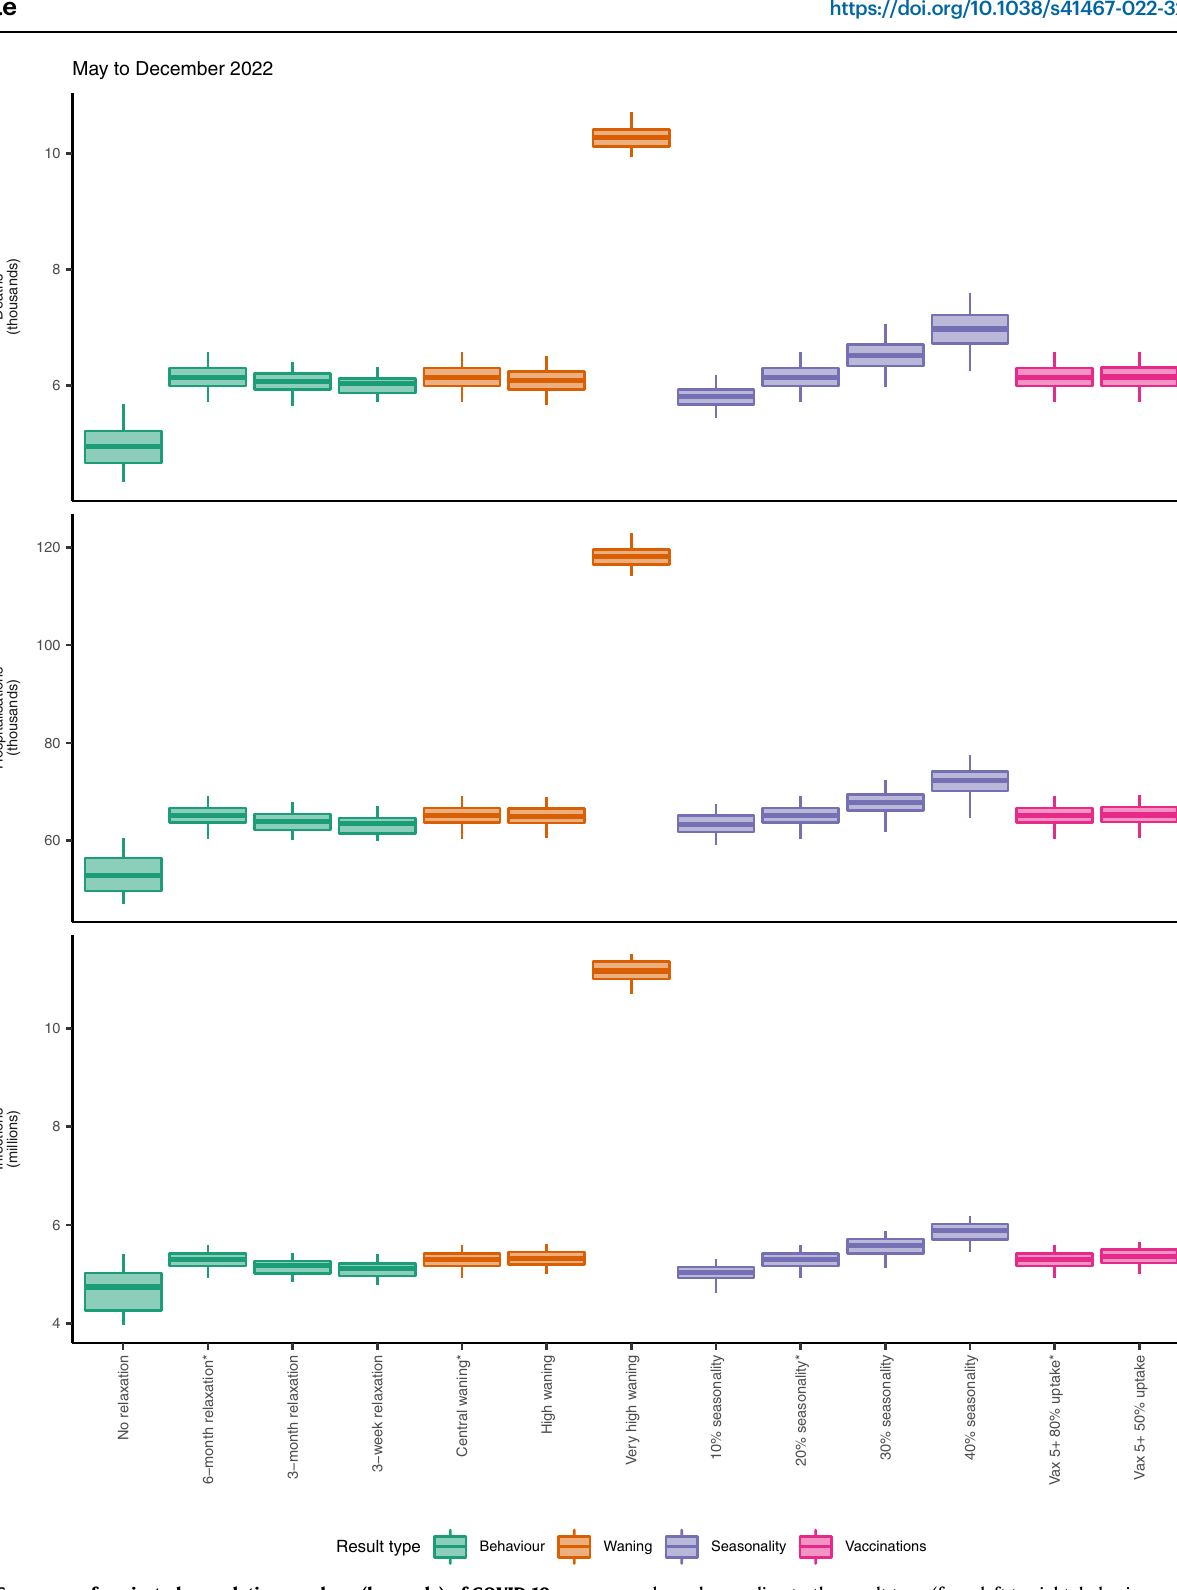
Fig. 5 | Summary of projected cumulative numbers (log-scale) of COVID-19 deaths (thousands), hospital admissions (thousands) and infections (millions) in England between May and December 2022, across behavioural, waning, seasonality and vaccination scenarios considered. Each box plot shows the projected median (central line), 5th (minima), 25th (lower bound of box), 75th (upper bound of box) and 95th (maxima) percentile values across 100 simulations foreachrelevantscenario,calculated betweenMayandDecember2022.Scenarios